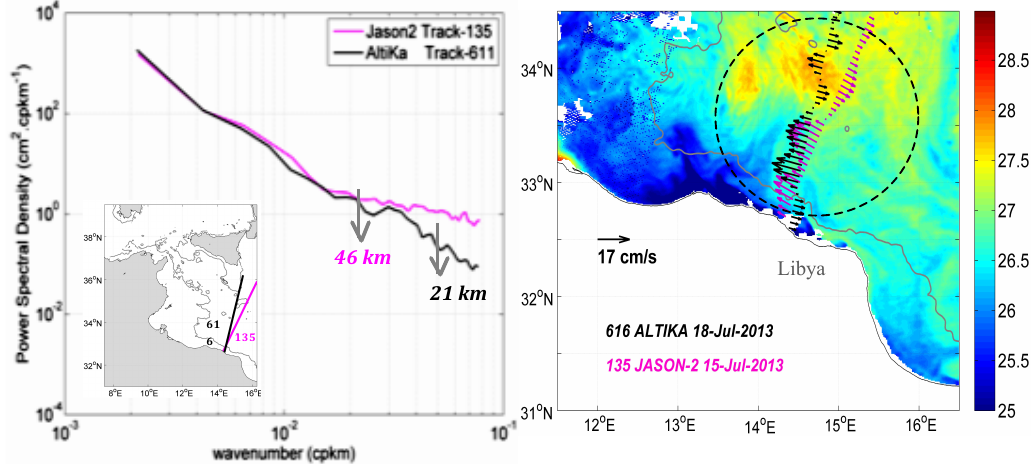
Figure 4. ( Left ) Wavenumber spectra from SSH observed in the Central Mediterranean Sea along the track 616 of SARAL/AltiKa (black) and along the track 135 of Jason-2 (pink); and ( Right ) comparisons of SST (in ◦ C) with SARAL/AltiKa track 616 (black) and Jason-2 track 135 (pink) crosstrack velocities over the Tunisia-Lybian shelf for 18 July 2013. The SST pattern is derived from CMEMS products with 1/16 ◦ resolution. The 200 m isobath (in grey) is derived from the ETOPO2v1 database. The black dashed circle indicates the location of the Sidra